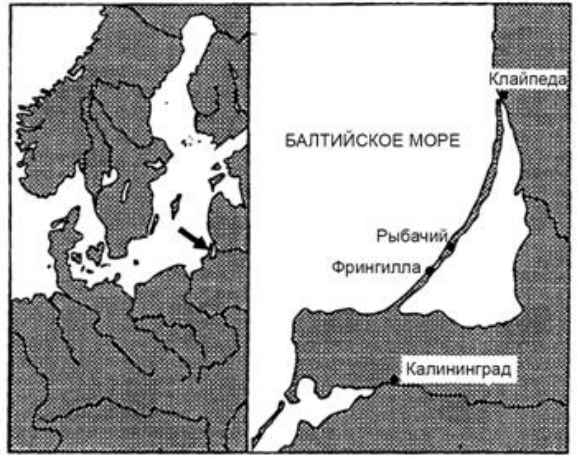
Рис. 1. Карта района исследований на Куршской